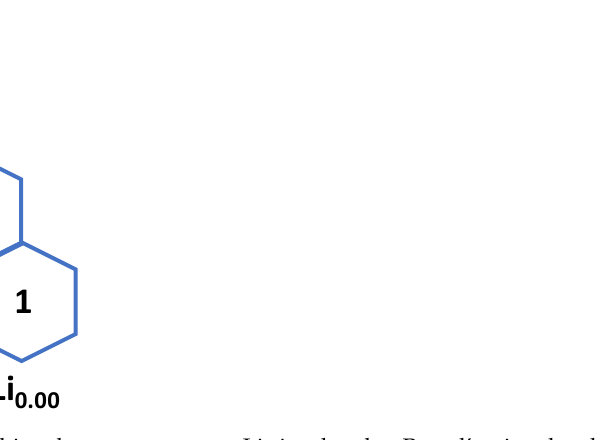
Figure 1. The total number of delithiated structures across Li x is related to Pascal’s triangle where each row increases the total number of Li at Li 1.00 by one. Sums of the row equal the total number of configurations in the charge cycle.